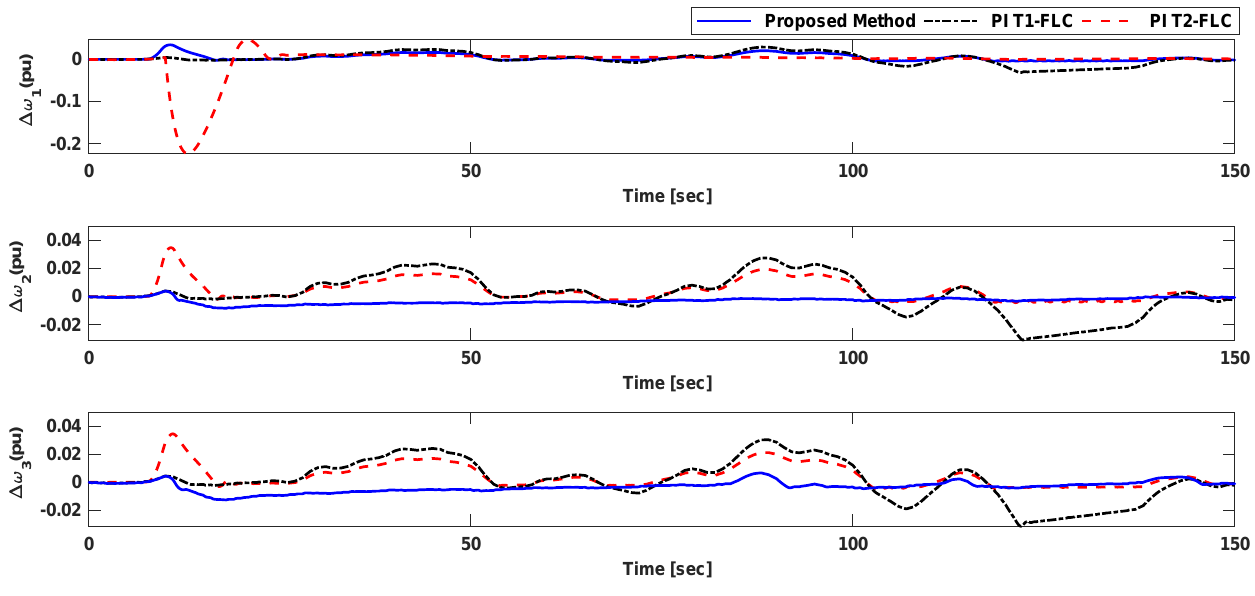
Figure 15. Example 2: Scenario 3: The trajectory of frequency regulation for all three areas. Table 5. Example 2: Performance comparison for different control